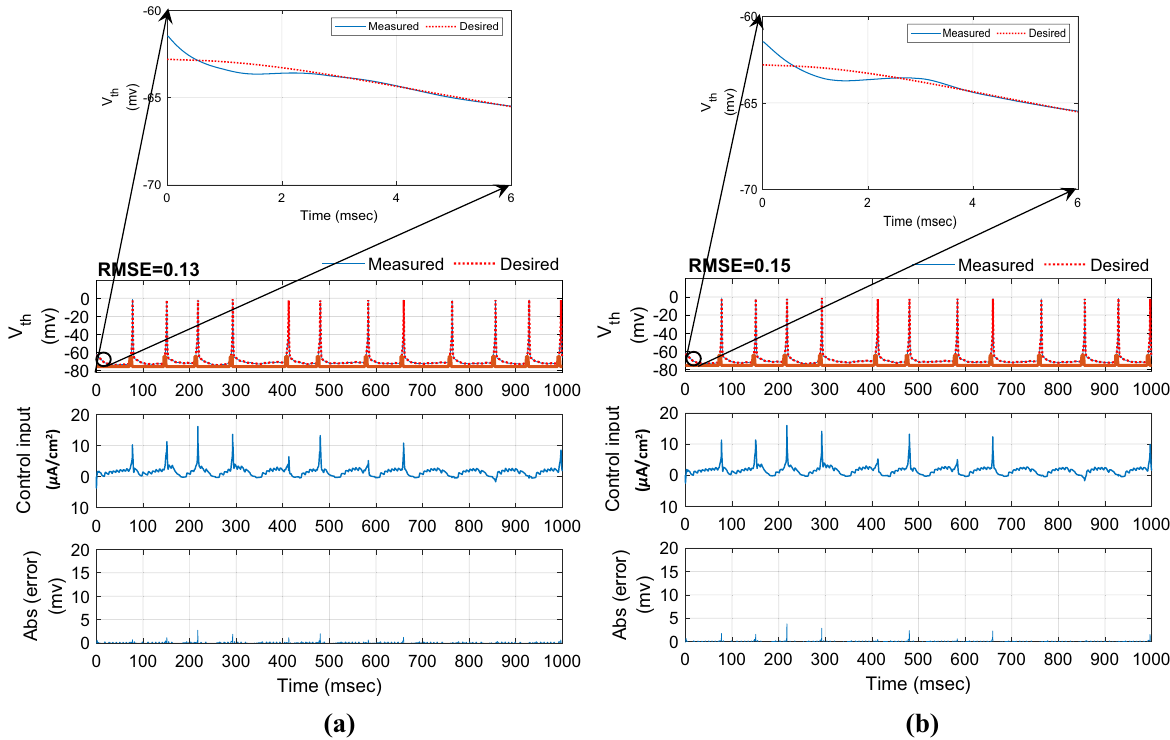
Figure 4. Typical results of the closed-loop control for neuron 1 using ( a ) AFTSMC ( b ) AFSMC.